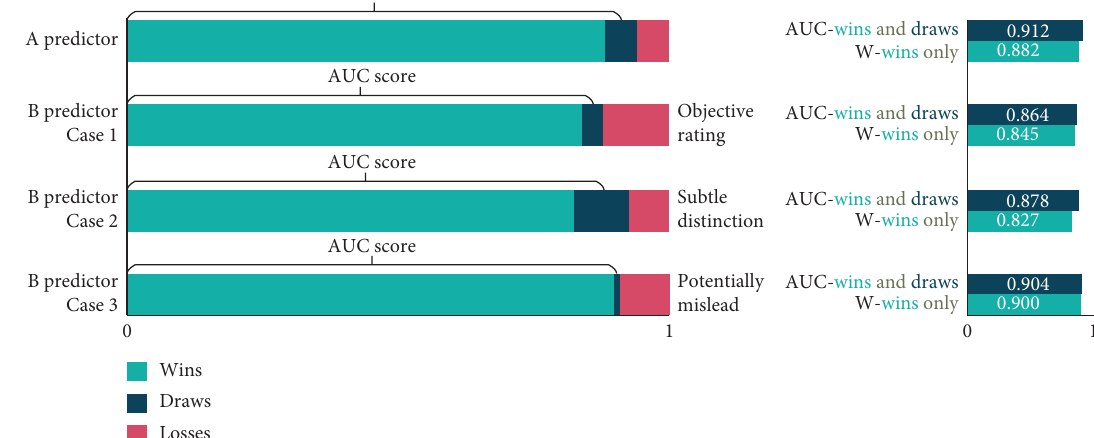
Figure 1: Two side effects of the draws for the evaluation of link prediction